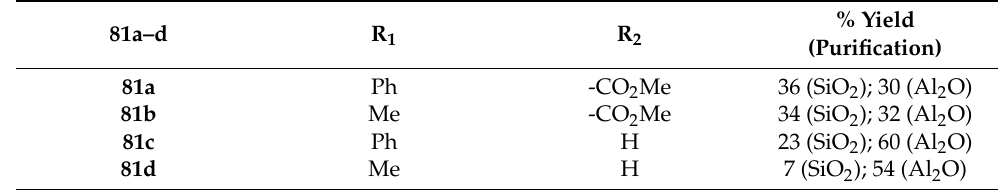
Table 2. Substitution pattern and percentage yields of benzodiazepines 81a – d .